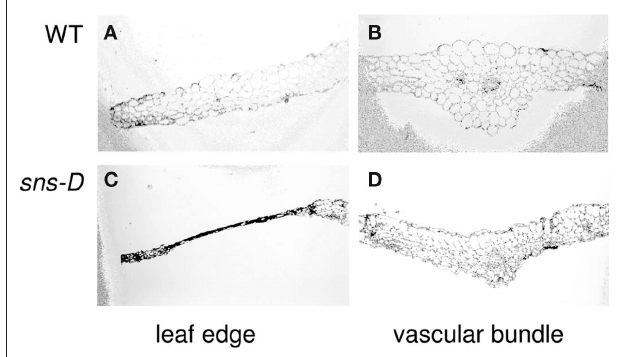
FIgURe 7 | Anatomical analysis of wild-type and sns-D leaves. Cross-sections were made from rosette leaves from 2-week-old plants grown in soil. (A,B) wild-type, (C,D) Mutant sns-D showing cross section through a necrotic spot (C) .